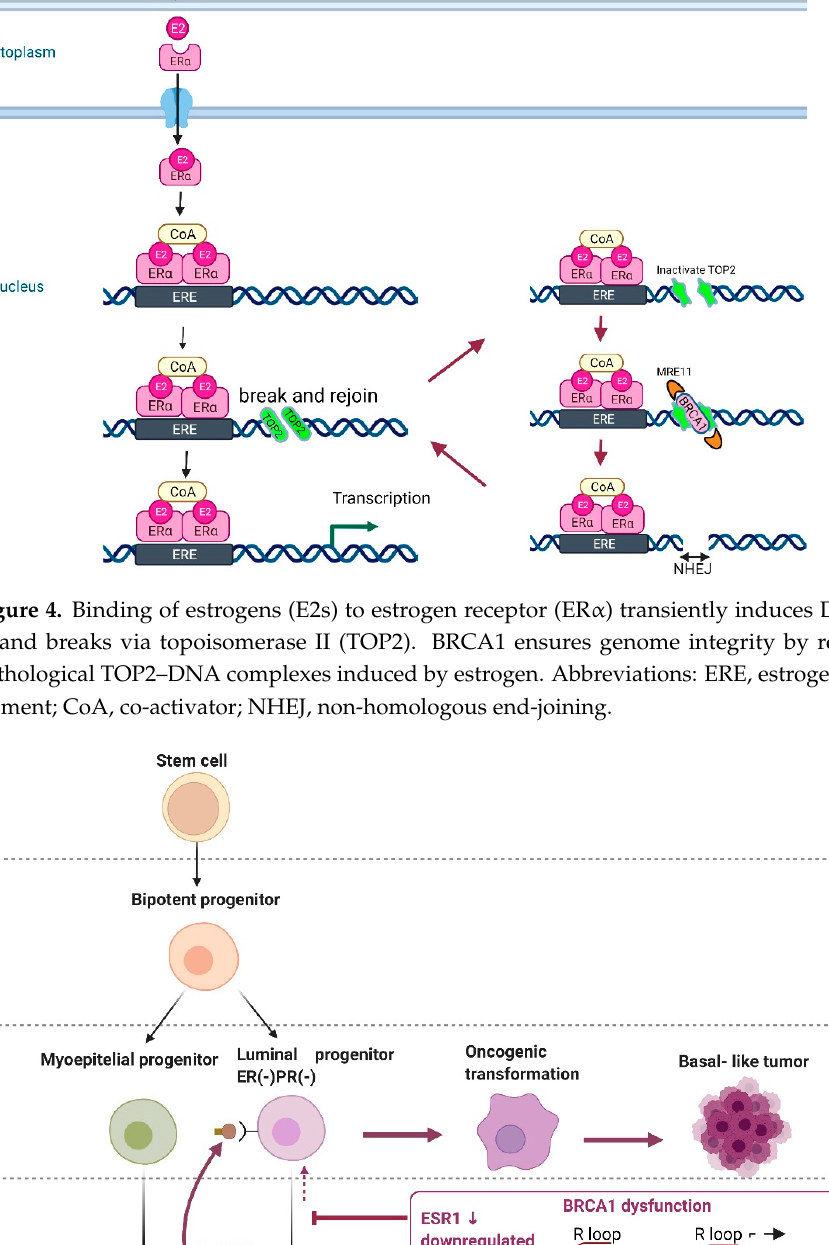
Figure 5. Carcinogenic mechanism of basal-like breast cancer (BC). Dysregulation of ESR1 transcrip-